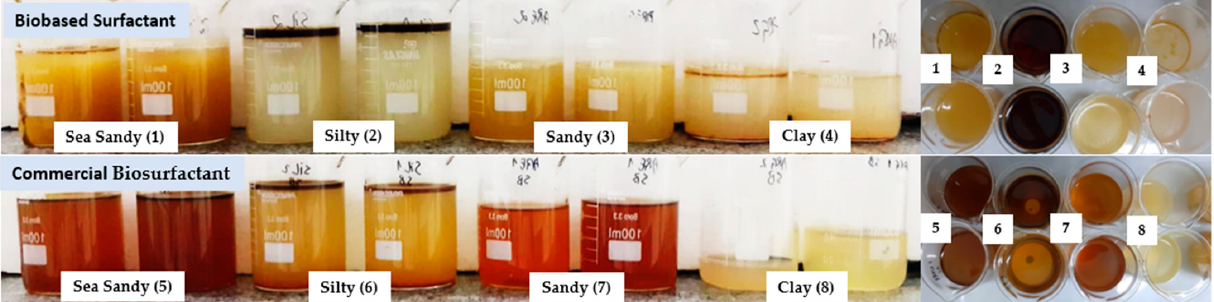
Figure 17. Images of surfactants washing solutions after contaminant removal from soils through static treatment. The removal of motor oil from the contaminated soil was carried out through the saturation of 100 g of soil with 10 g of motor oil.